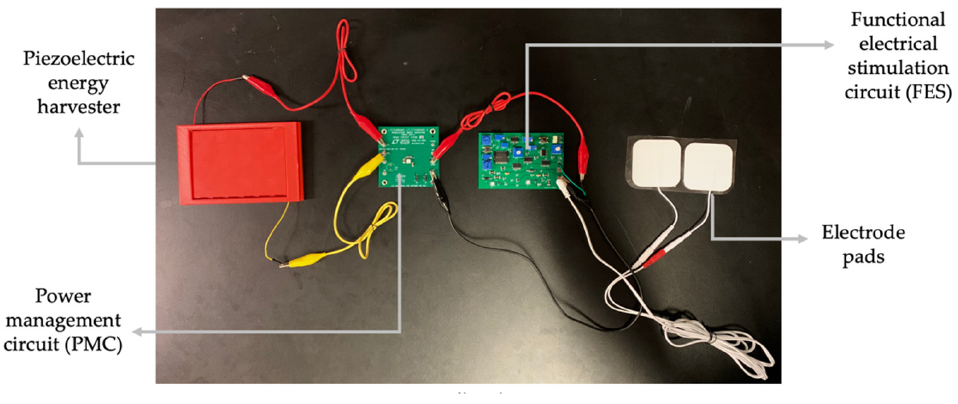
Figure 4. Full-scale prototype components.